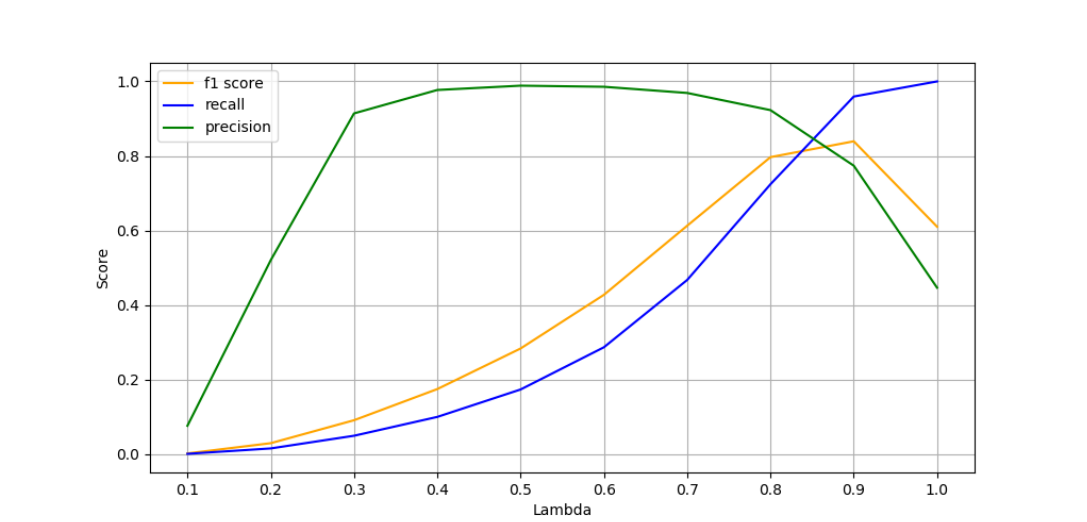
Figure 7. The accuracy variation of energy-based filtering as λ is